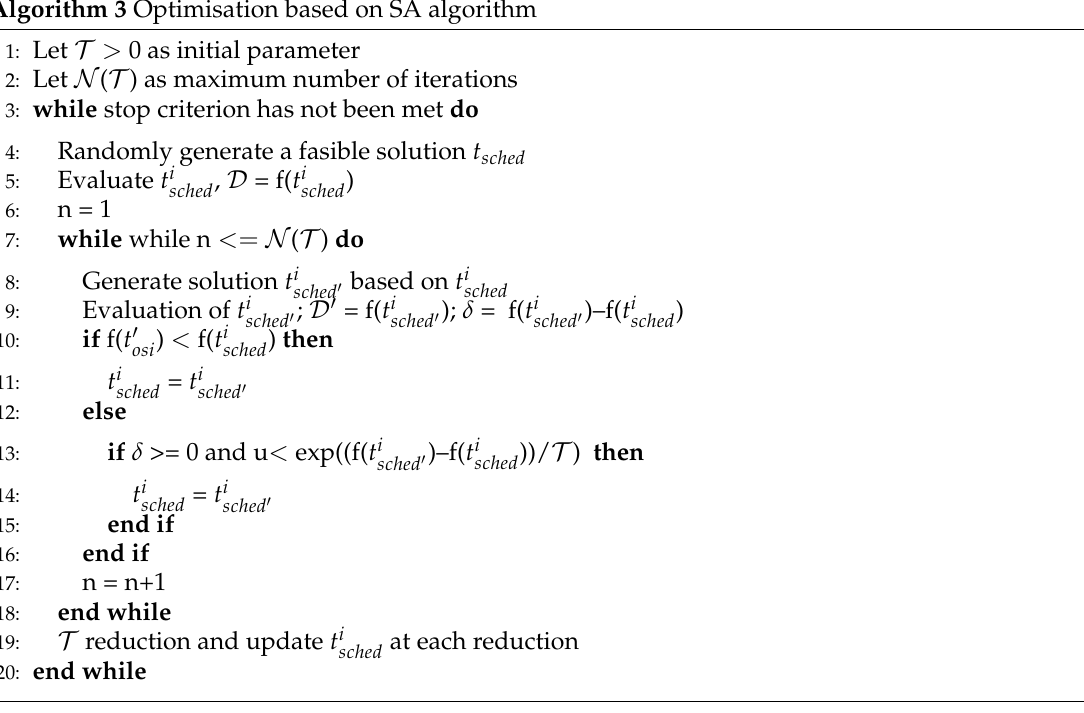
Algorithm 3 Optimisation based on SA